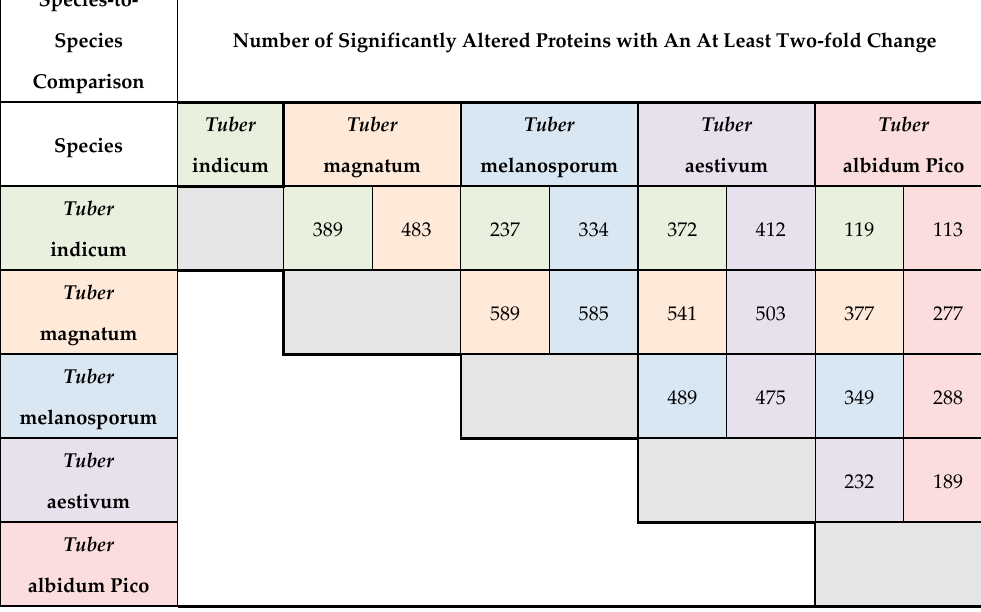
Figure 4. Results of the species-to-species comparison listing the number of 1% FDR T-test significant proteins upregulated with an at least two-fold change. Colors correspond to truffle species. Comparisons of species are done horizontally versus vertically. The number of significantly upregulated proteins with an at least two-fold change is listed for each species-against-species comparison. As there are two numbers resulting from each comparison (upregulated in species horizontally listed and upregulated in species vertically listed), the numbers are color coded accordingly to the species they belong to.